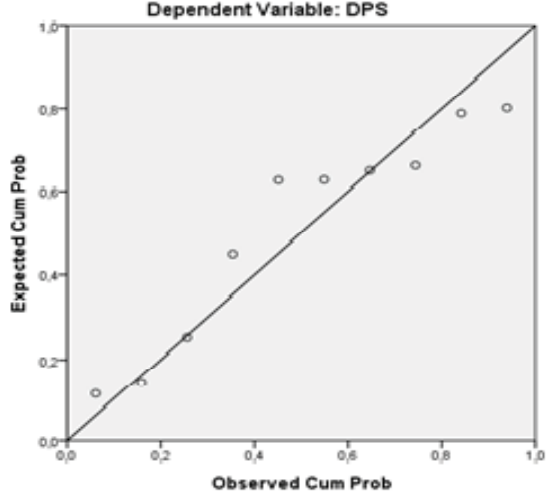
Fig. 1. Statistical Result of Normality Plots (cid:105) Multicollinearity To test the multicollinearity, normality test is